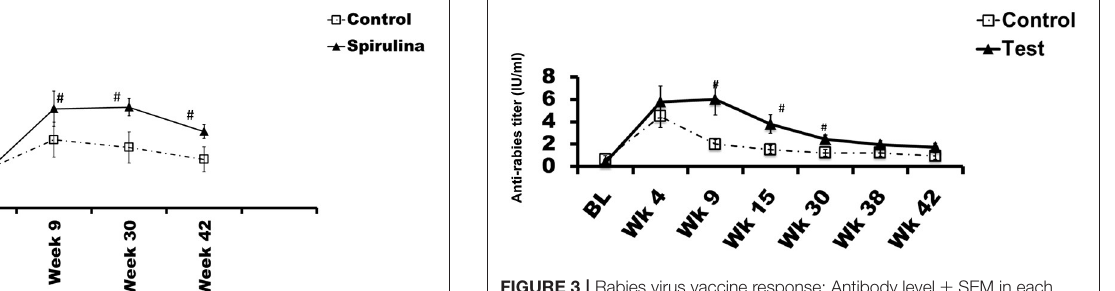
FIGURE 3 | Rabies virus vaccine response: Antibody level ± SEM in each group during the trial is plotted. X-axis represents time in weeks and Y-axis represents anti-rabies virus titers in IU/ml. # p < 0.05. BL denotes baseline